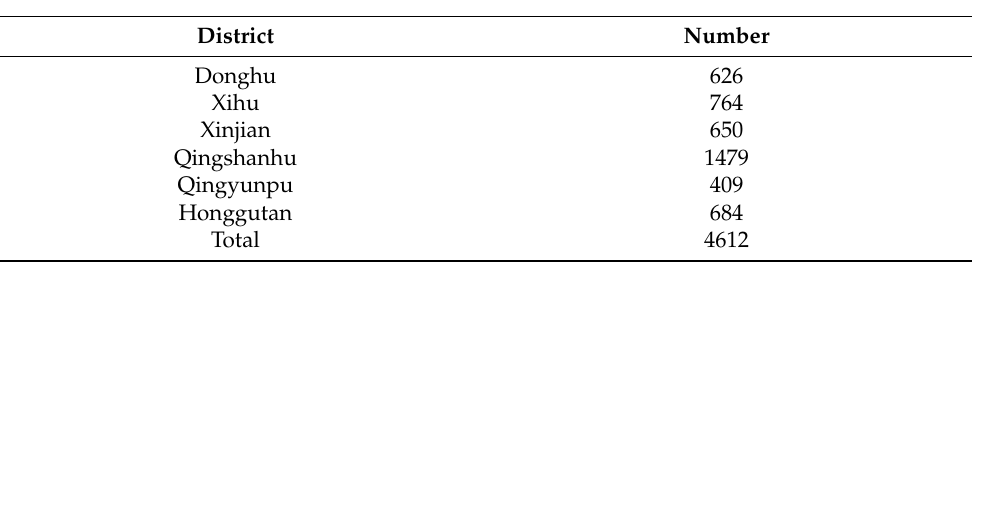
Figure 2. Data collected in the study area. Table 1. Settlements in each